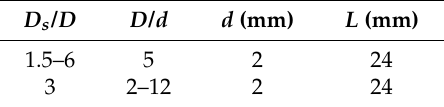
Table 3. Geometric parameters of the organ